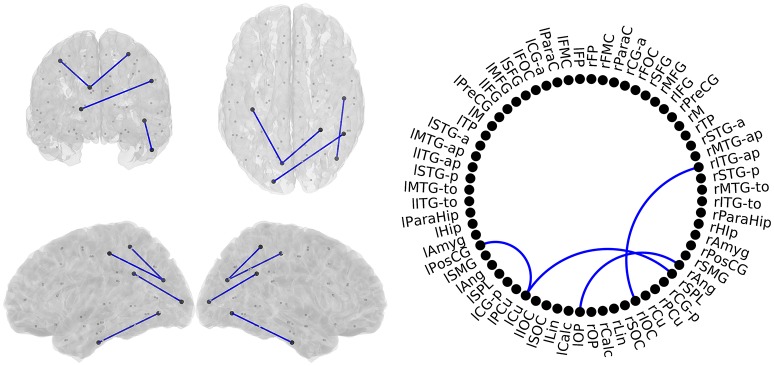
Links with significantly different FC-values in the comparison between Subjective Cognitive Decline (SCD) and Mild Cognitive Impairment (MCI) groups. Left: Posterior, superior, left and right views of the brain. Right Circle plot shows a schematic view of the significant links. Blue lines indicate a decreased FC-value in MCI respect to SCD.